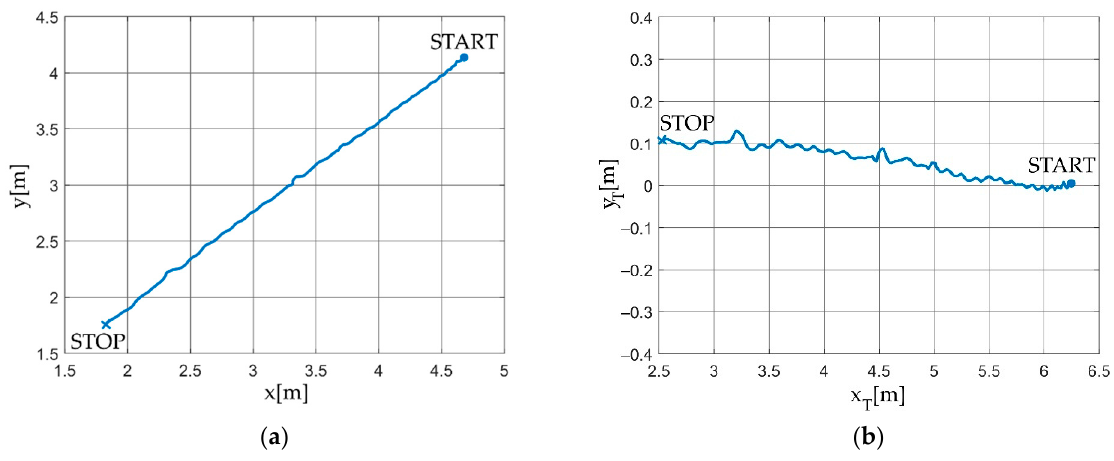
Figure 16. The path of the characteristic point of the GO1 robot related to the retroreflector in ( a ) the original coordinate system; ( b ) transformed coordinate system.